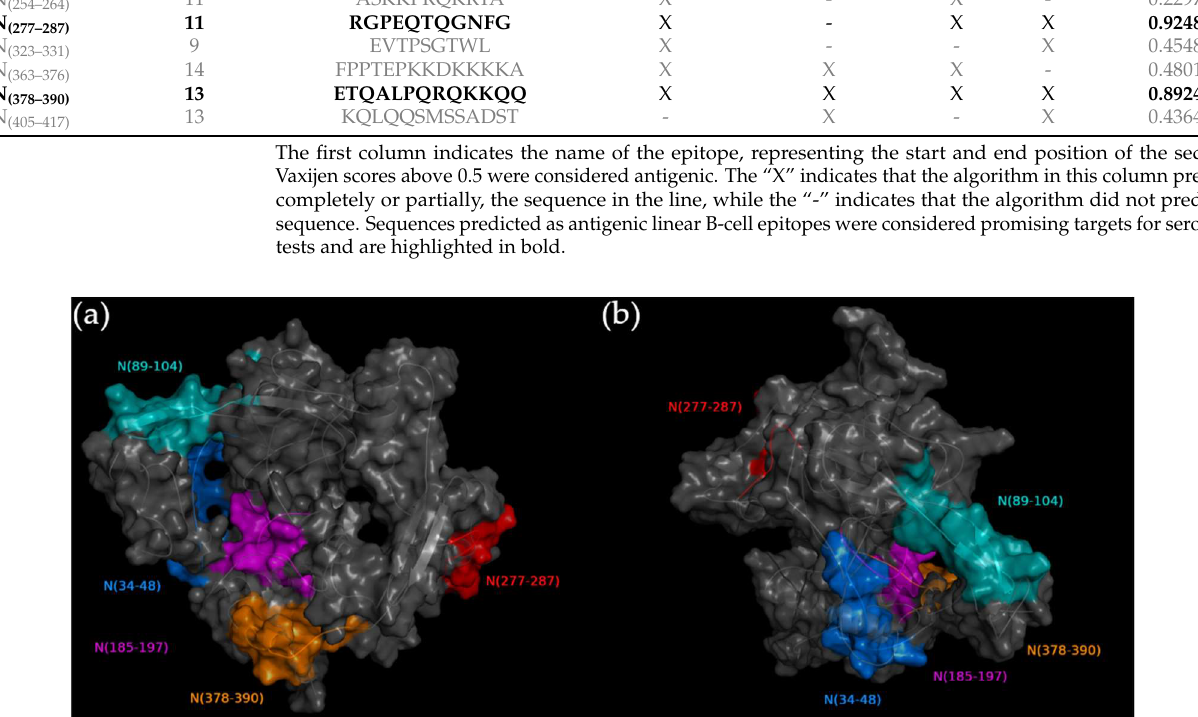
Table 1. Evaluation of potential serological targets in SARS-CoV-2 N protein.